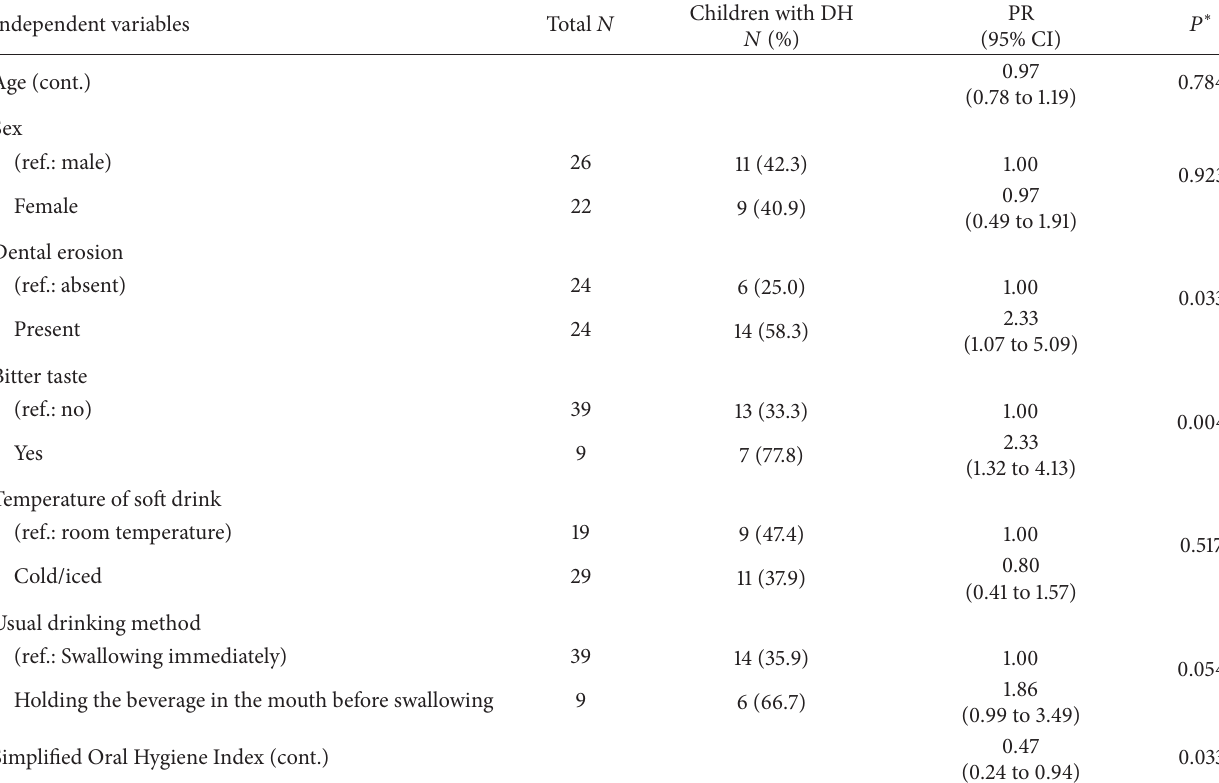
Table 1: Univariate Poisson regression analysis of possible factors related to the child associated with dental hypersensitivity. Independent variables Total